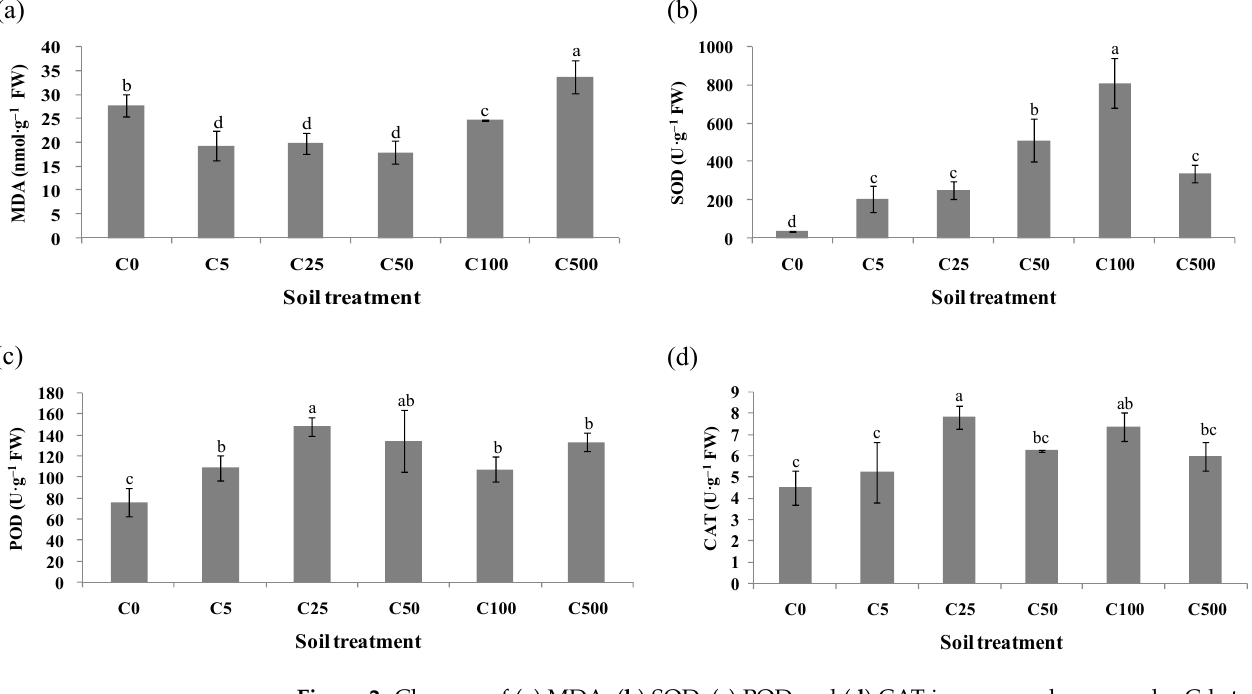
Figure 2. Changes of ( a ) MDA, ( b ) SOD, ( c ) POD and ( d ) CAT in ryegrass leaves under Cd stress. Values are expressed as means of three replicates with standard deviations ( ± SD). Different lowercase letters indicate that values are significantly different at p < 0.05.